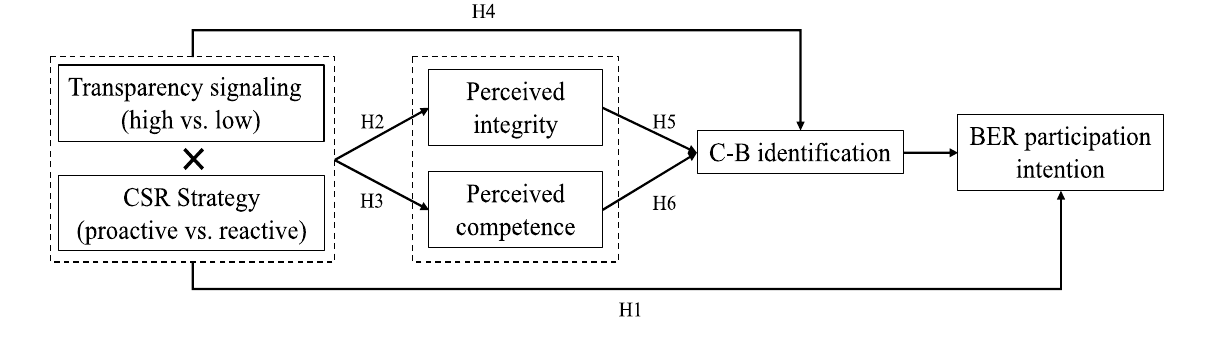
Figure 1. Proposed research model.